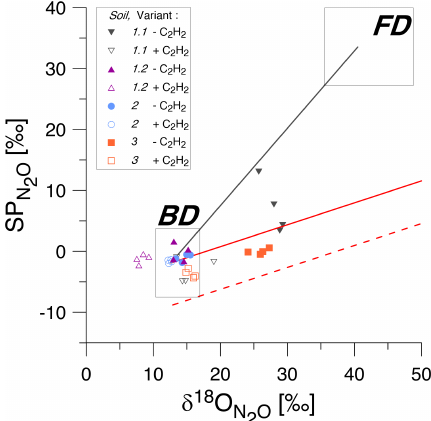
Figure 3. SP/ δ 18 O isotope mapping approach (SP/ δ 18 O Map) to es- timate the contribution of bacteria or fungi to N 2 O produced accord- ing to Lewicka-Szczebak et al. (2017, 2020). The isotopic values for natural abundance treatments with acetylene addition ( + C 2 H 2 , empty symbols) and without acetylene addition ( − C 2 H 2 , corre- sponding filled symbols) are shown for four soils (1 to 3). The grey rectangles indicate expected ranges of isotopic signatures for het- erotrophic bacterial denitrification (BD) and fungal denitrification (FD) (Yu et al., 2020). The solid black line is the mixing line con- necting the average expected values for BD and FD, while the solid red line is the mean reduction (for the mean SP values for BD) line and the dashed red line is the minimum reduction line (for the min- imal SP N values for 2 O